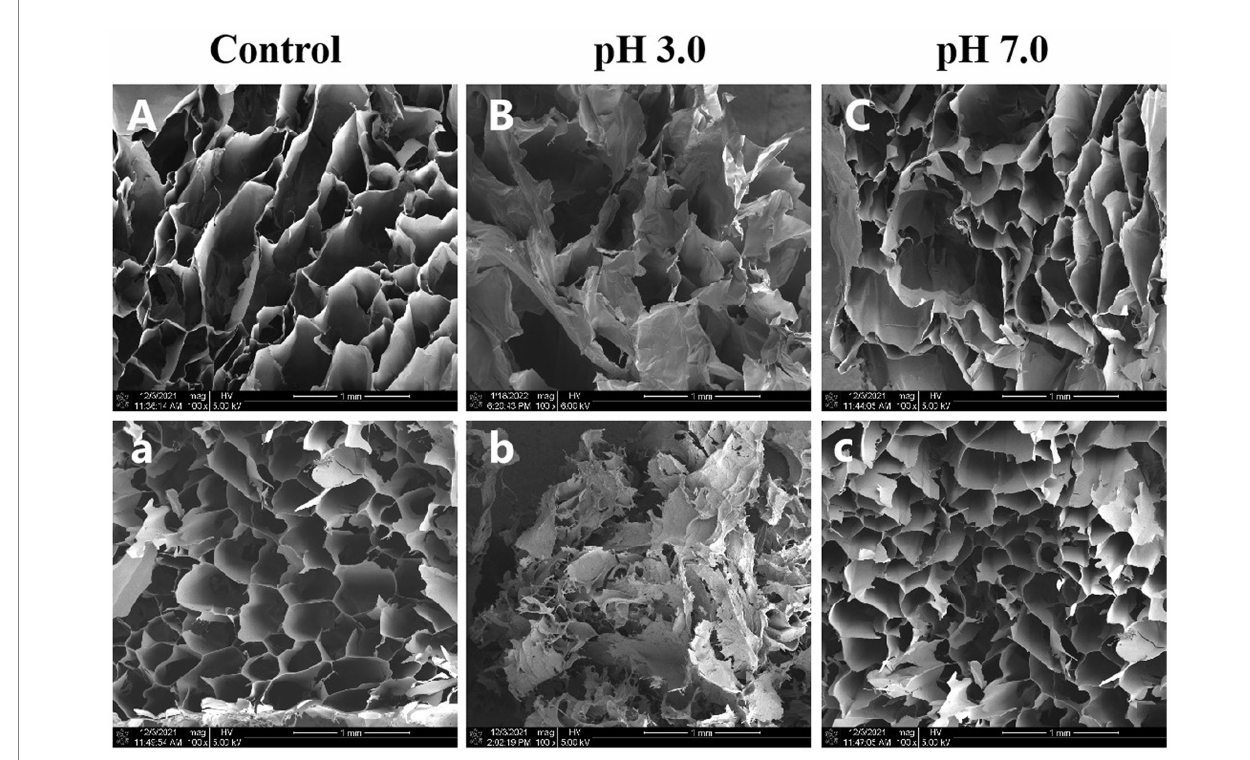
FIGURE 3 Effects of physiological pH in the simulated gastrointestinal phase on the microstructure of κ -CGN (A–C) and κ -CC (a–c)